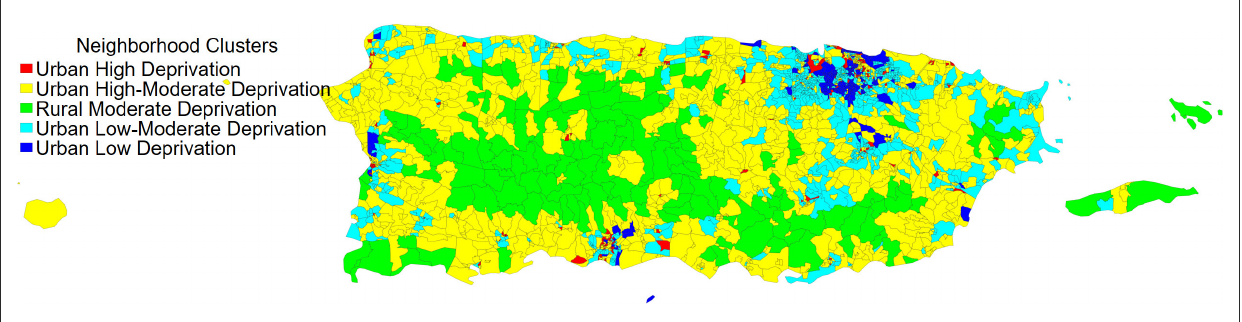
FIGURE1 The distribution of neighborhood clusters by year 2000 census block groups in Puerto Rico. Data source: 2000U.S. Decennial